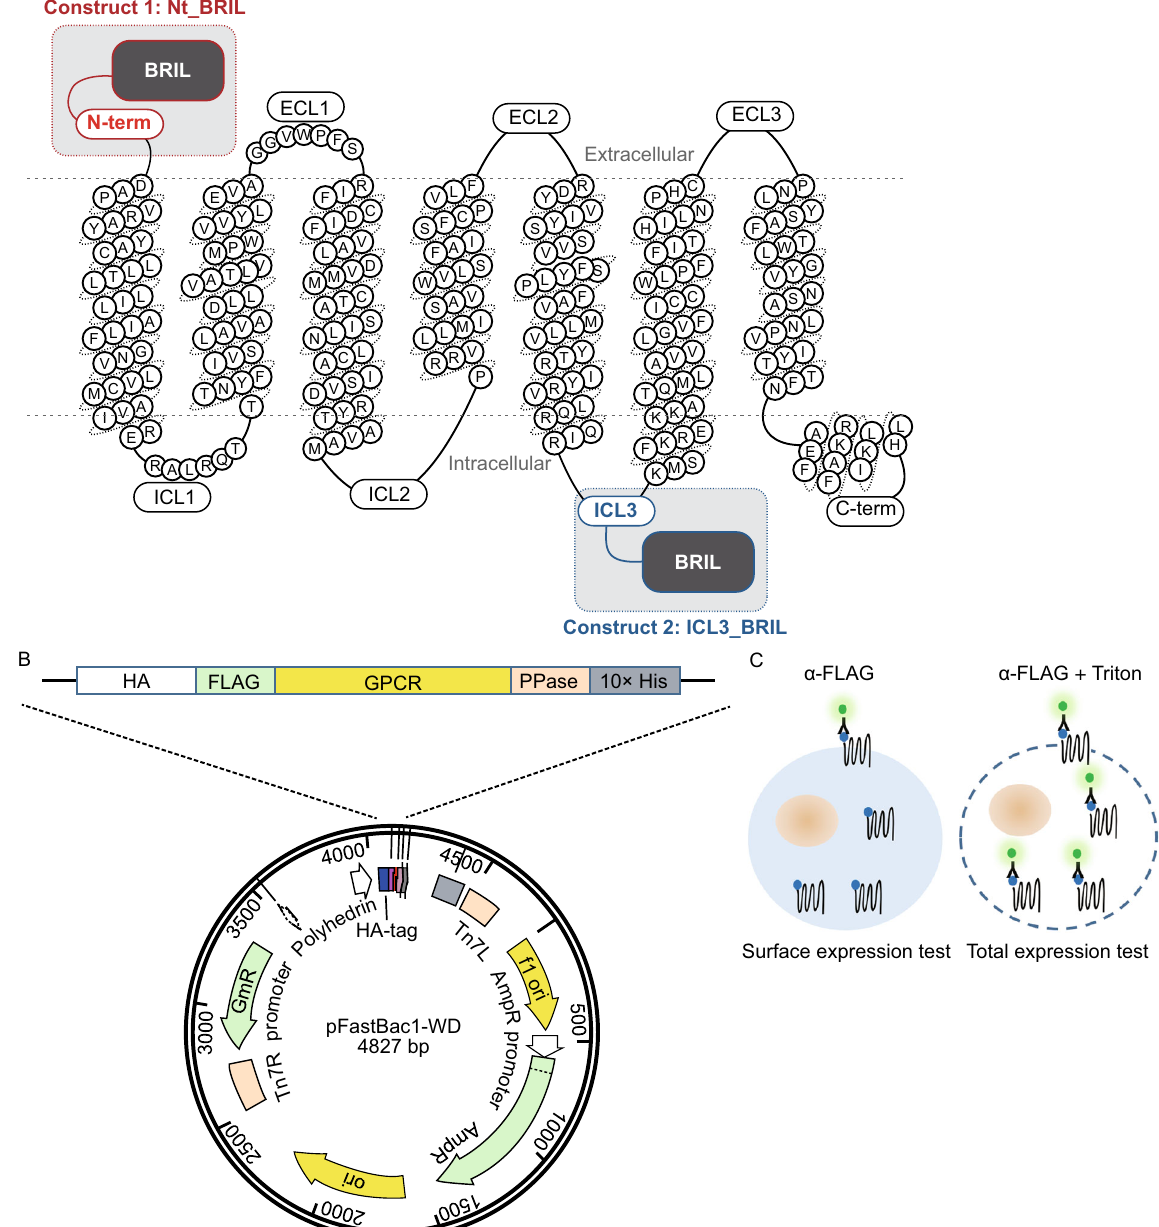
Figure 2. Experimental design. (A) Constructs were designed by truncating the fl exible N- and C-termini and inserting BRIL at either the N-terminus (Nt_BRIL) or intracellular loop 3 (ICL3_BRIL). (B) Constructs were then inserted into the pFastBac 1 vector for Sf9 expression. (C) FITC fl uorescence was used to measure the percentage of cells expressing the GPCR, as well as density of GPCRs for those cells. Surface and total expression were measured by adding α - fl ag FITC with and without Triton,